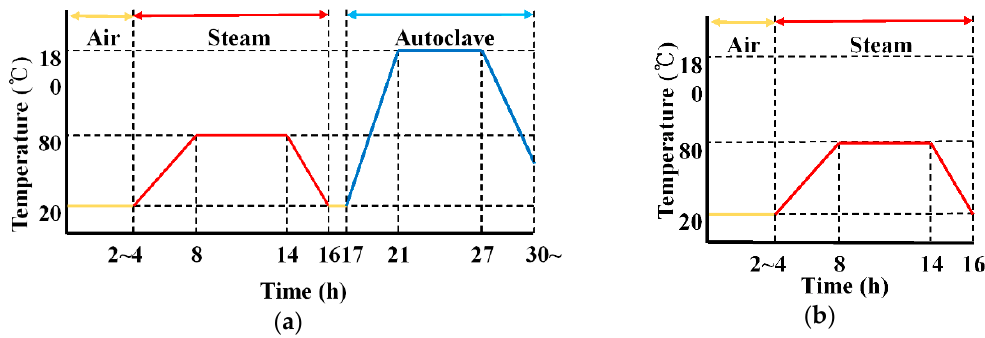
( h ) Figure 1. Production method of extrusion panel: ( a ) mixer; ( b ) mixing materials; ( c ) setting of extrusion machine; ( d ) input materials; ( e ) extrusion; ( f ) correction of horizontal; ( g ) manufacturing of panel; ( h ) surface of extrusion panel. 2.2. Curing Methods For the curing of the specimen molded by extrusion, room temperature curing and atmospheric pressure steam curing were performed, as shown in Figure 2, and high-pressure steam curing was performed for the base in which only cement was used. The curing at room temperature was performed in a constant temperature and humidity chamber under temperatures of 20 ± 1 °C,